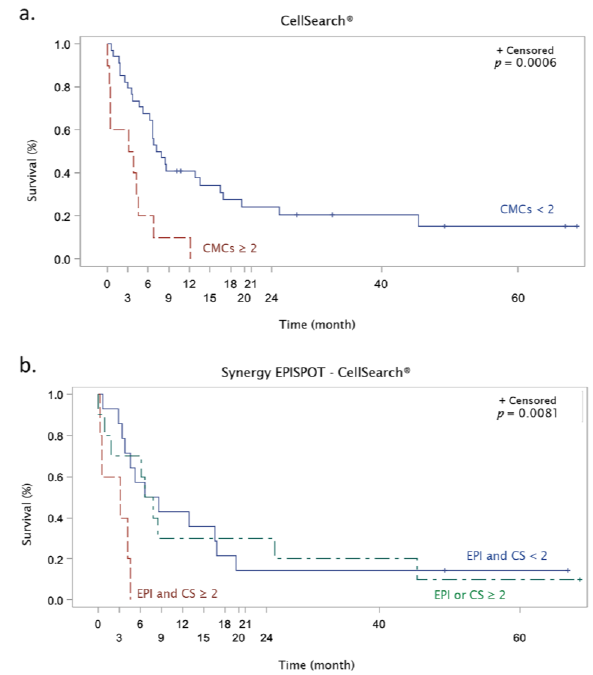
Figure 4. Kaplan–Meier survival curves of patients with metastatic melanoma according to the detection cut-o ff of 2 CMCs using the ( a ) CellSearch ® system, and ( b ) when combining the S100-EPISPOT (EPI) and CellSearch ® (CS) assay